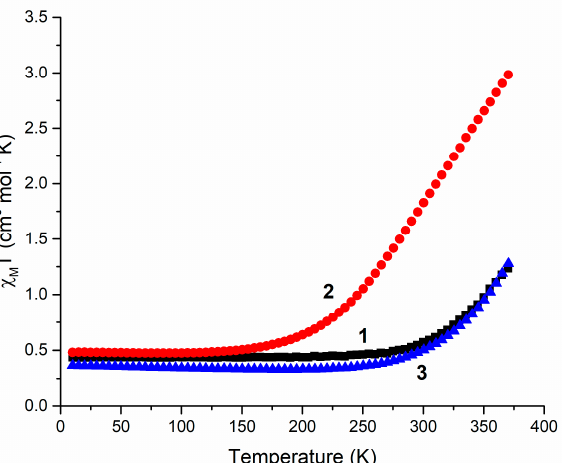
Figure 4. Temperature dependence of χ M T for complexes 1 – 3 , obtained under 0.1 T on cooling and warming (black squares for 1 , red circles for 2 , and blue triangles for 3 ).